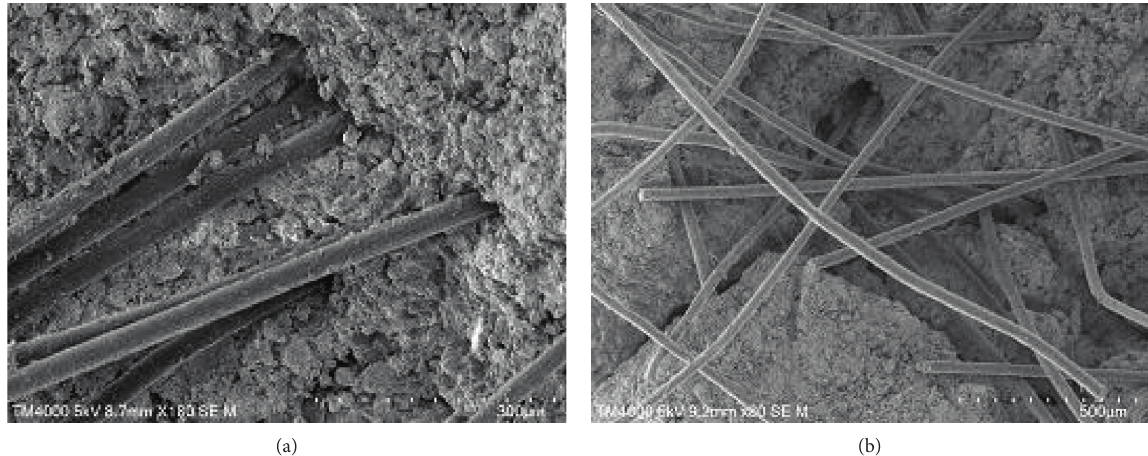
Figure 13: Fiber-reinforced soil. (a) One-dimensional lacing wire effect (180 times). (b) Three-dimensional network effect (80 times).